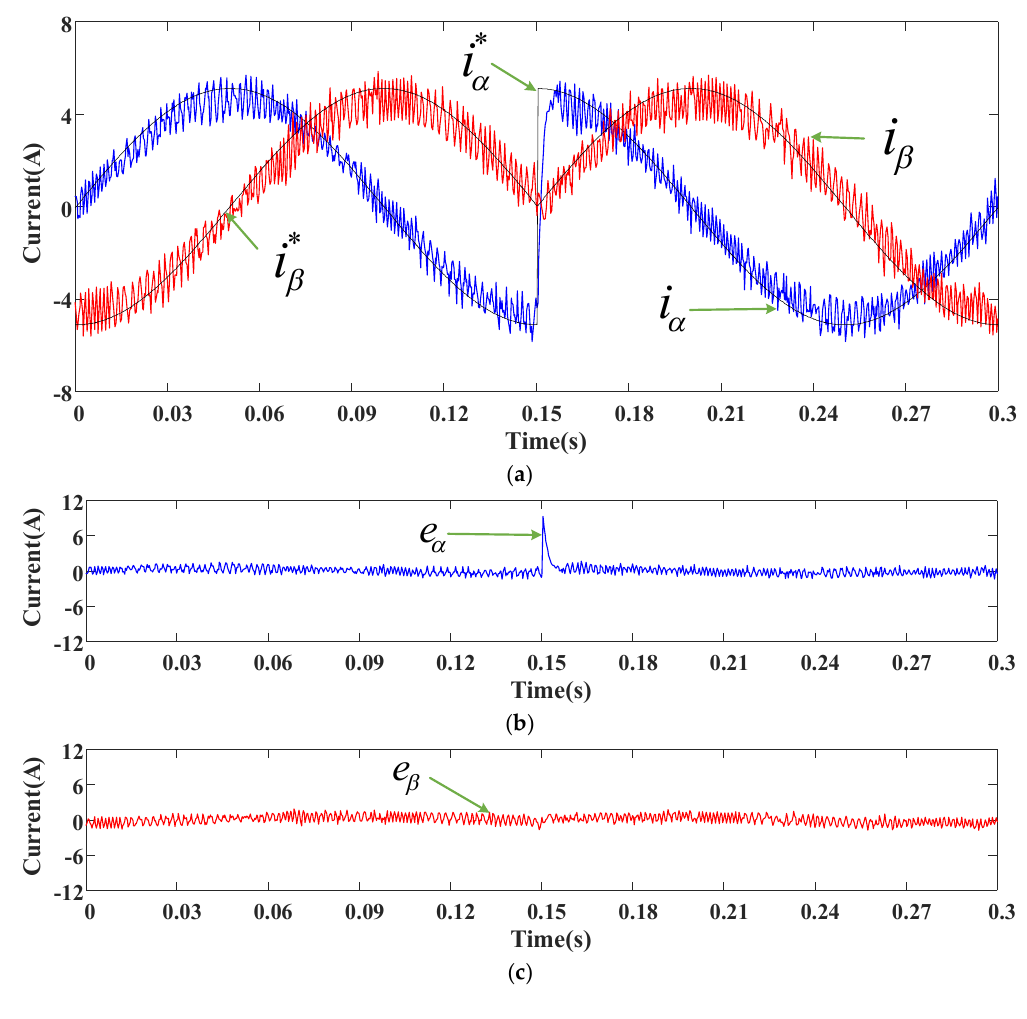
Figure 25. Experimental results of DVV-MPCC following a sinusoidal current command with current reversed at 0.15 s under frequency 10 Hz (case 5): ( a ) current responses; ( b ) α -axis current error; ( c ) β -axis current error.